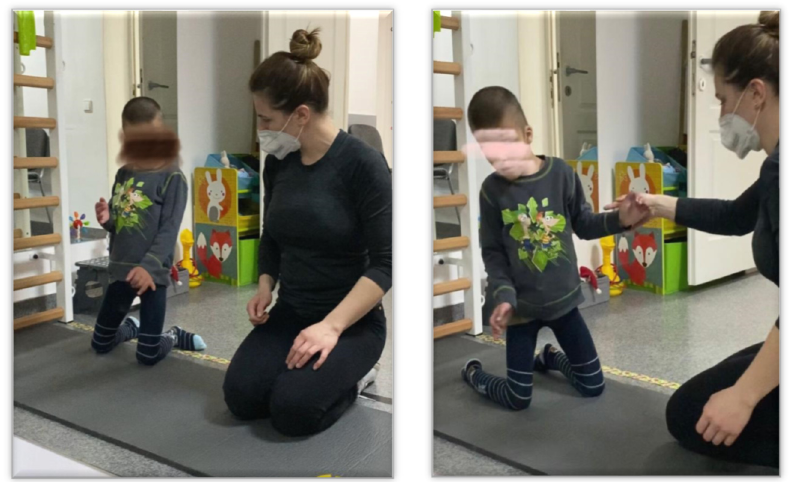
Figure 6. Imbalances from the “kneeling” position.